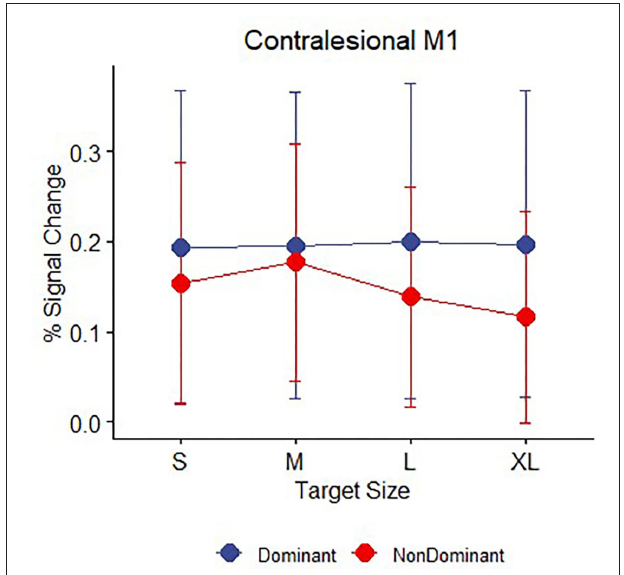
FIGURE 5 | Contralesional M1 mean BOLD response (percent signal change) during movement to targets for n = 16 patients with stroke divided by whether the affected hand was dominant (blue, n = 8) or non-dominant (red, n = 8) prior to their stroke. Error bars represent SEM.